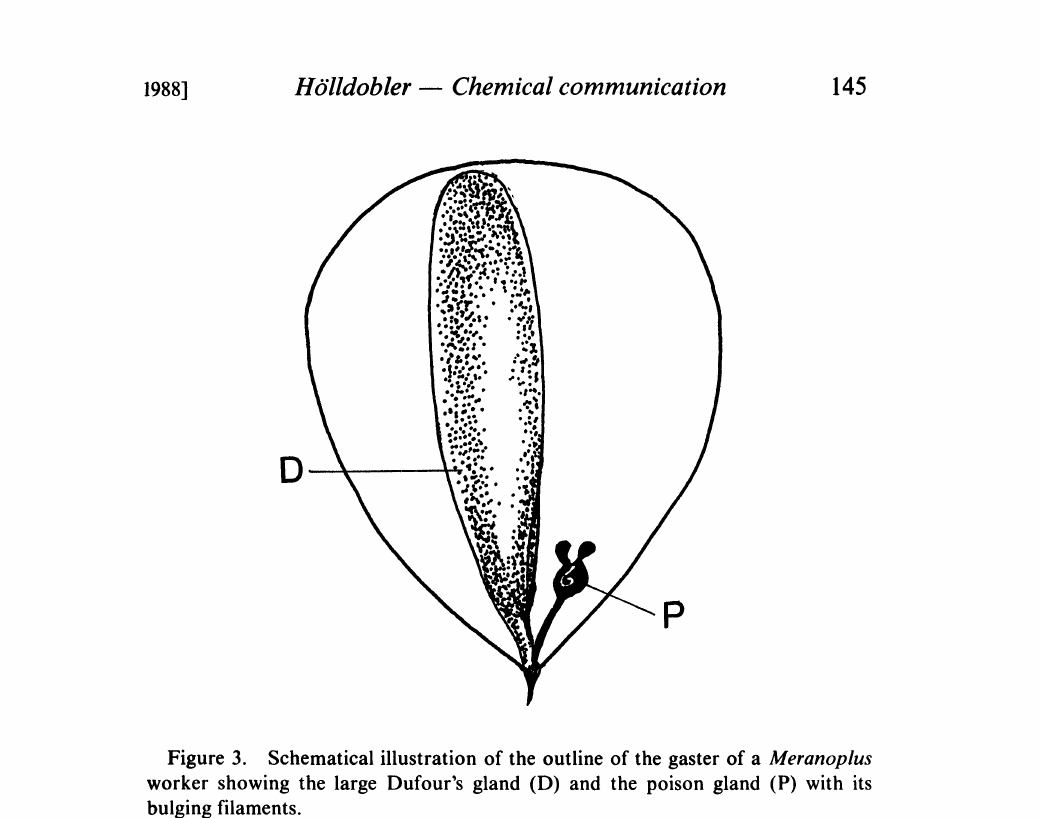
Figure 3. Schematical illustration of the outline of the gaster of a Meranoplus worker showing the large Dufour’s gland (D) and the poison gland (P) with its bulging